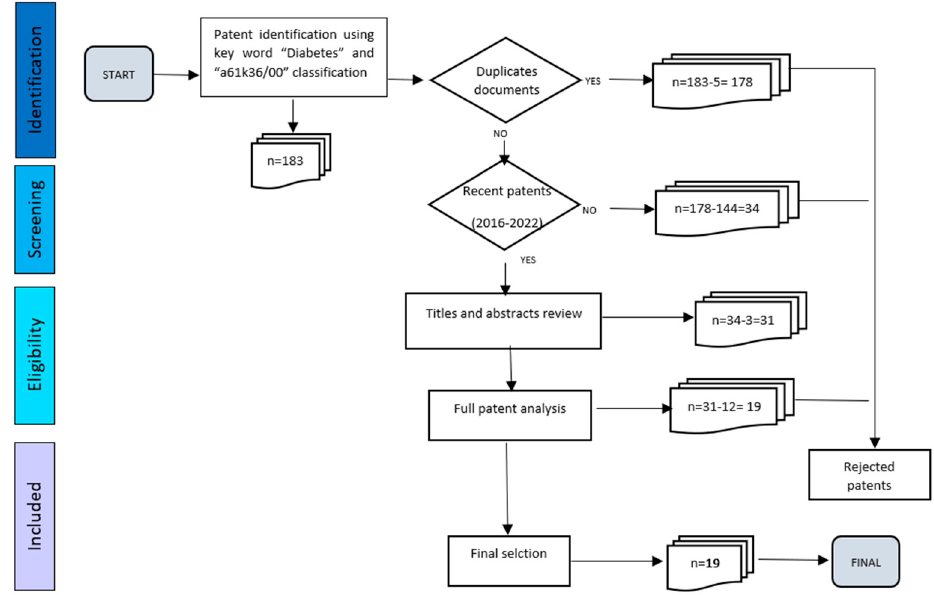
Figure 2. A systematic approach to the patent review with inclusion and exclusion criteria.